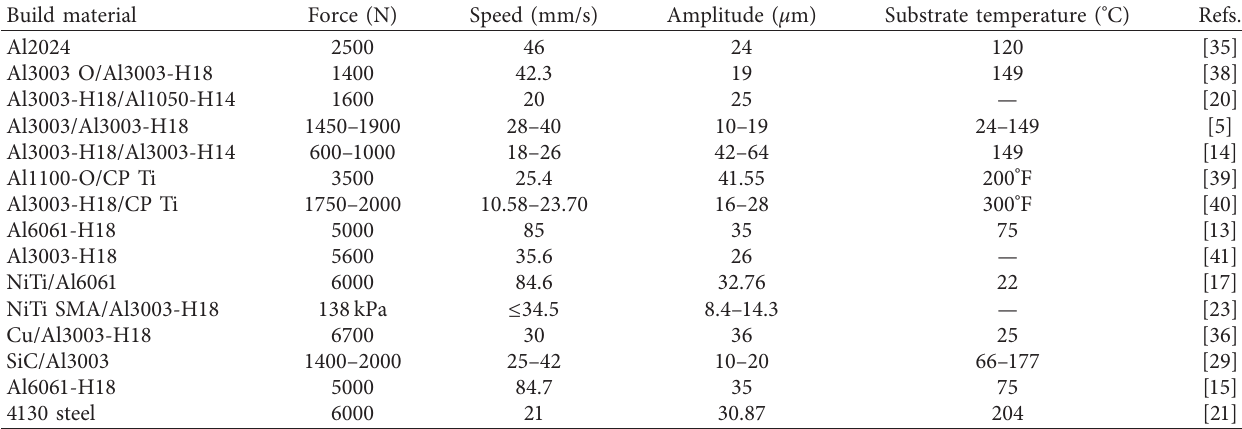
Table 1: UAM process parameters used by several authors.